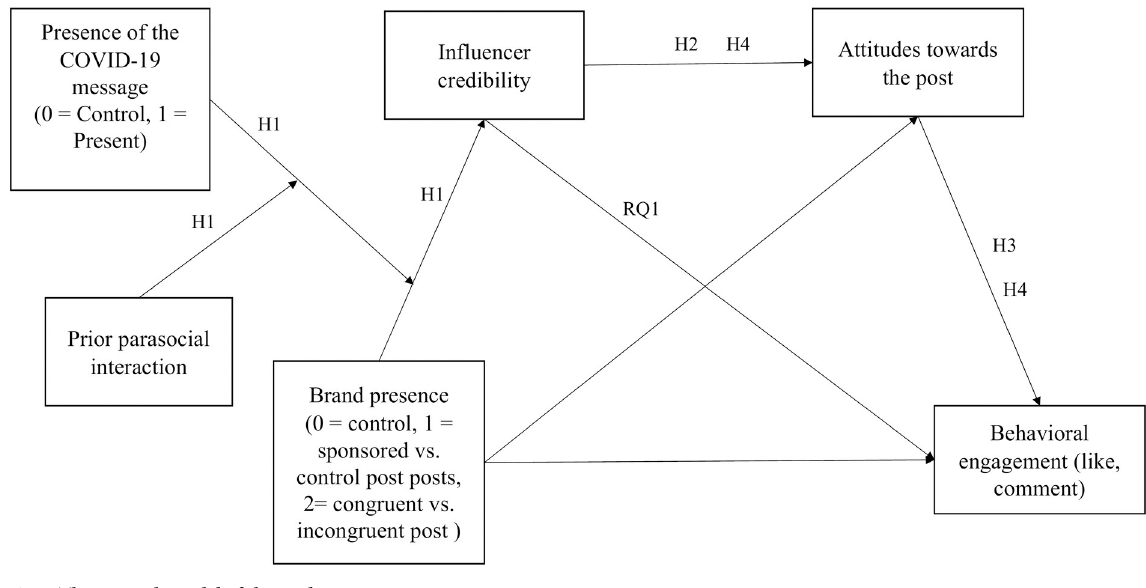
Fig 1. The research model of the